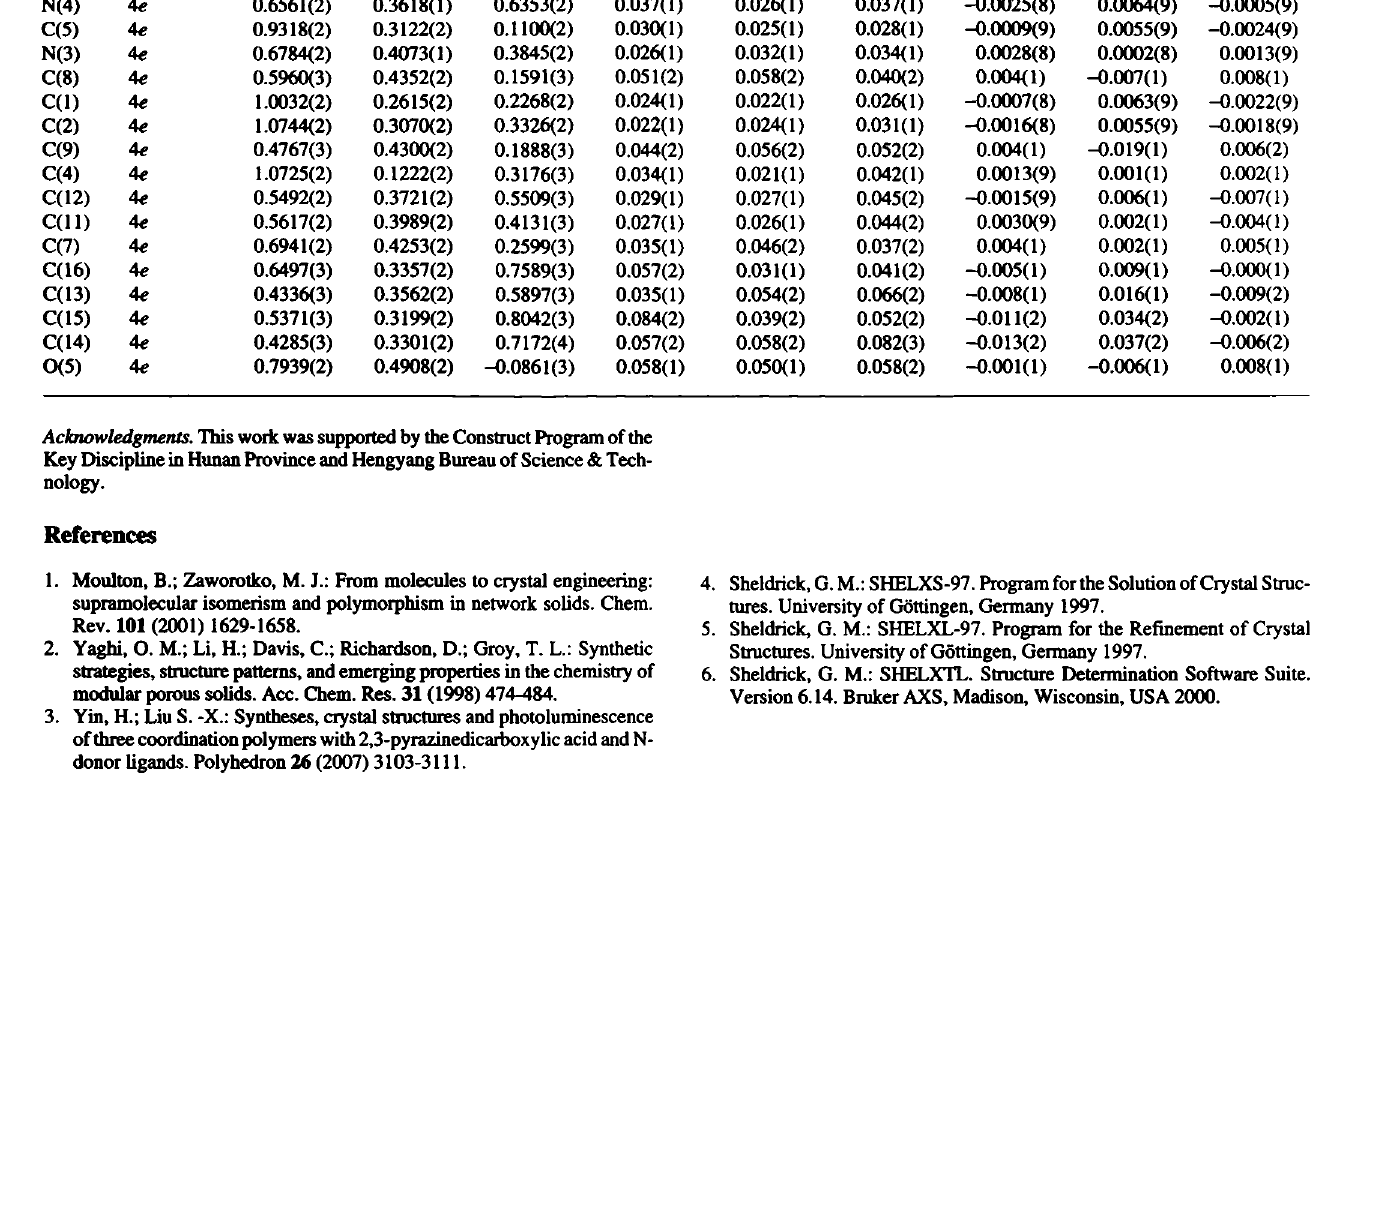
Table 3. Atomic coordinates and displacement parameters (in Ä 2